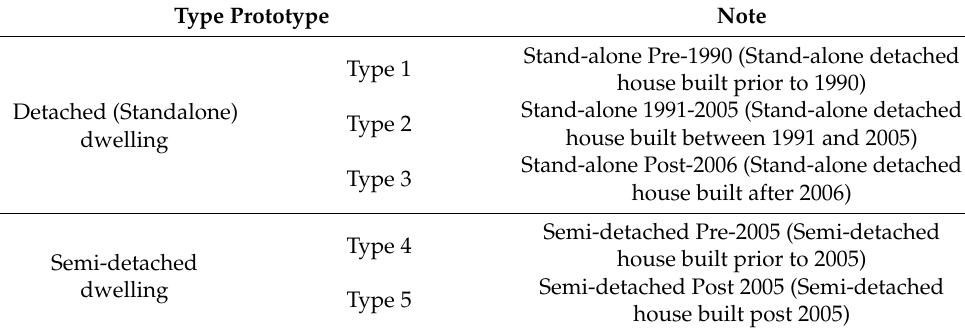
Table 3. Categorised dwelling prototypes of the residential building stock.